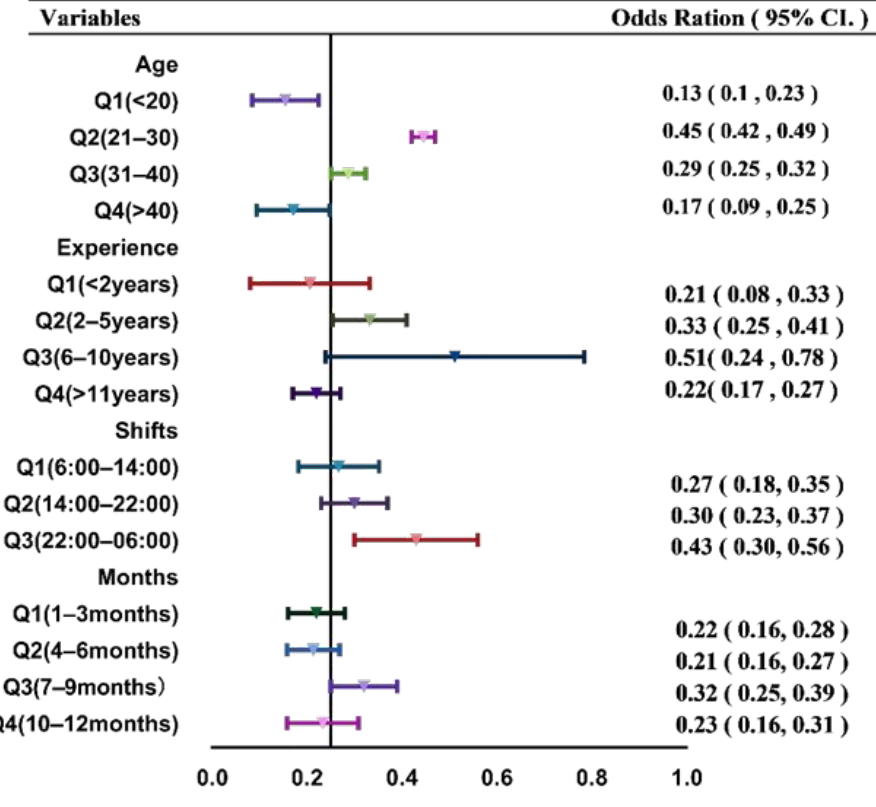
Figure 2. Associations of injuries with several risk factors among coal miners in China.